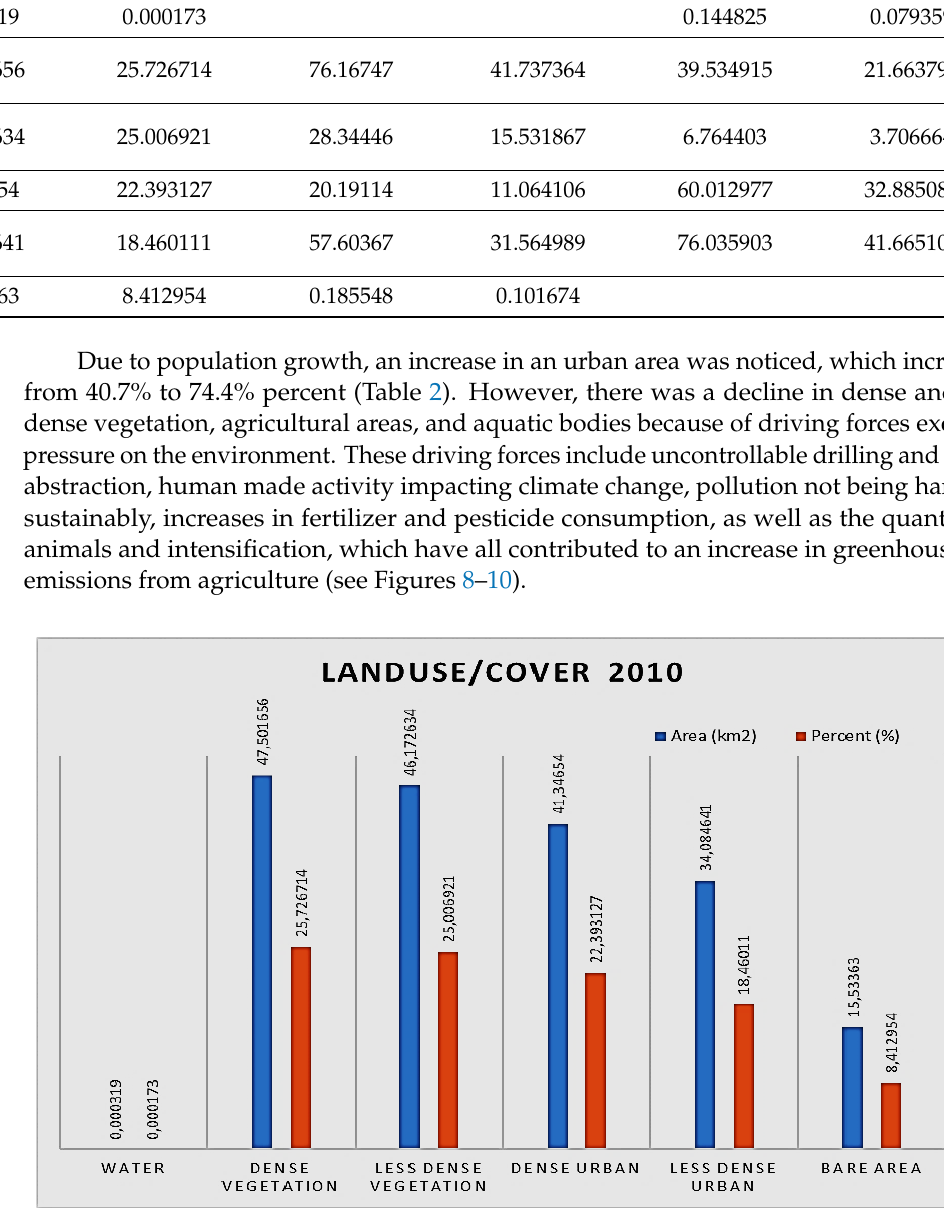
Figure 9. Land used/cover for 2015.